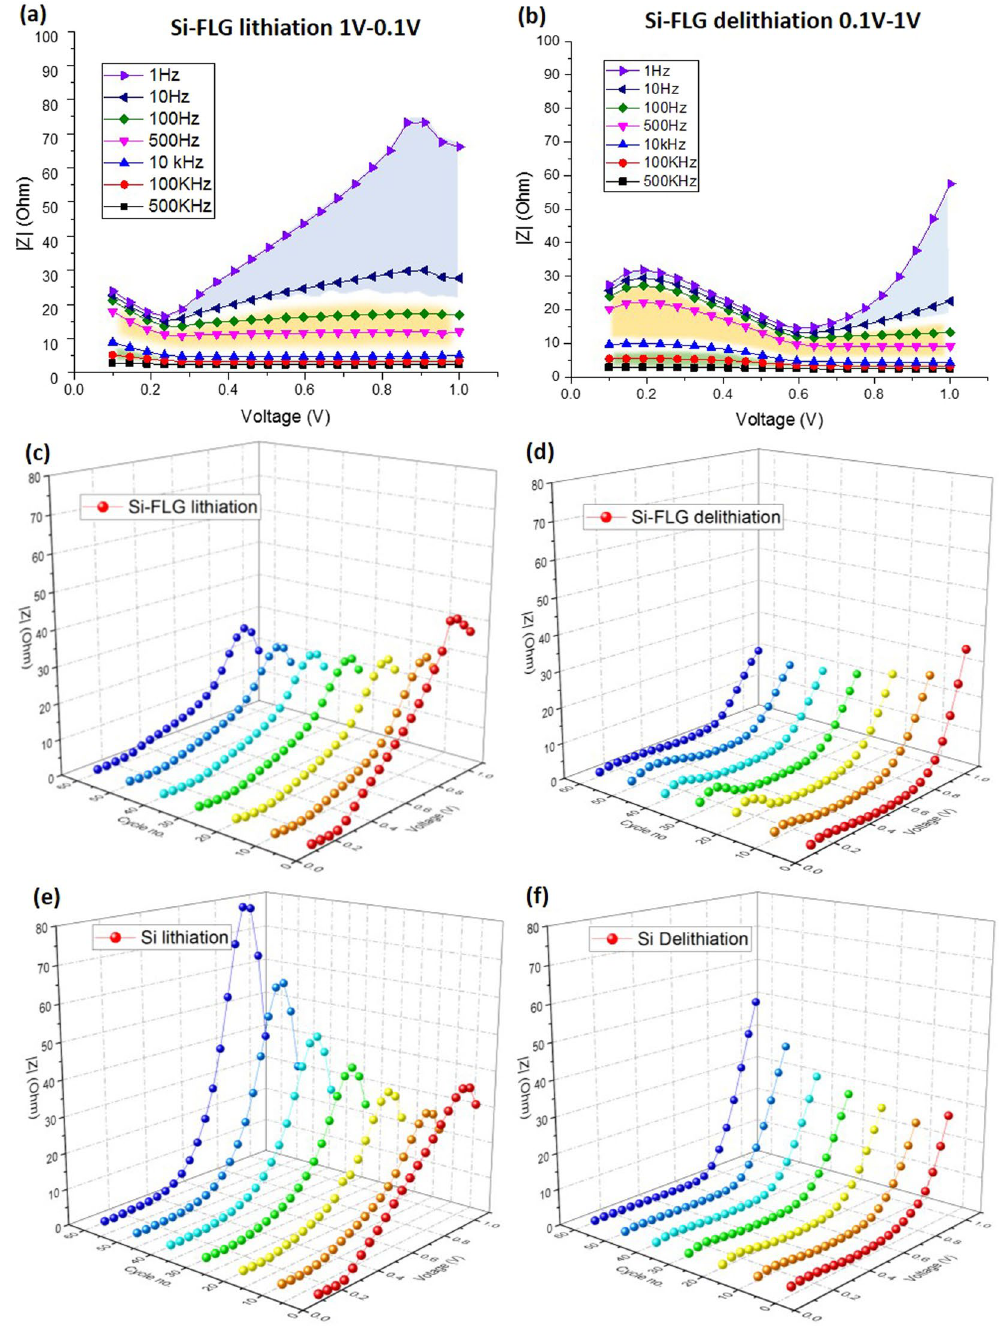
Figure 5. SPEIS result of Si-FLG after the first cycle for ( a ) lithiation process and ( b ) delithiation process; diffusion impedance at 1 Hz for Si-FLG ( c ) during lithiation and ( d ) delithiation process; and for Si ( e ) during lithiation and ( f ) delithiation